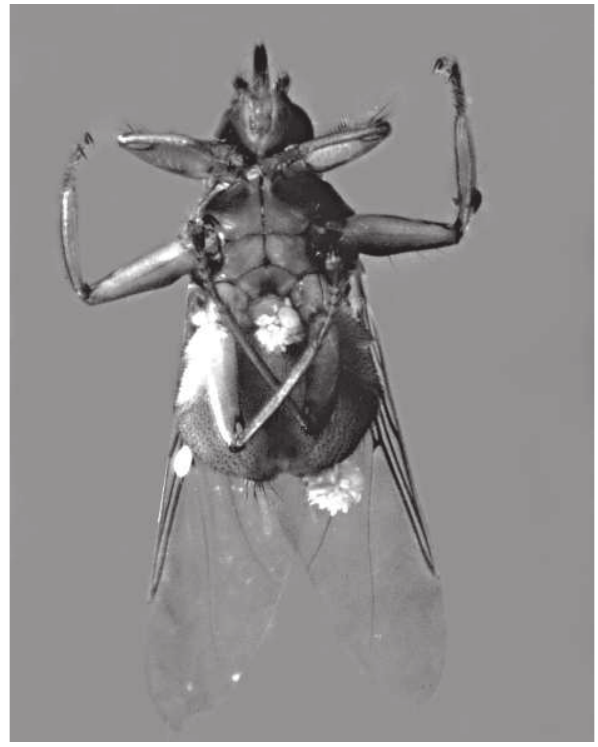
Fig. 1 – Ventral view of Pseudolynchia canariensis with mites and eggs ( ×